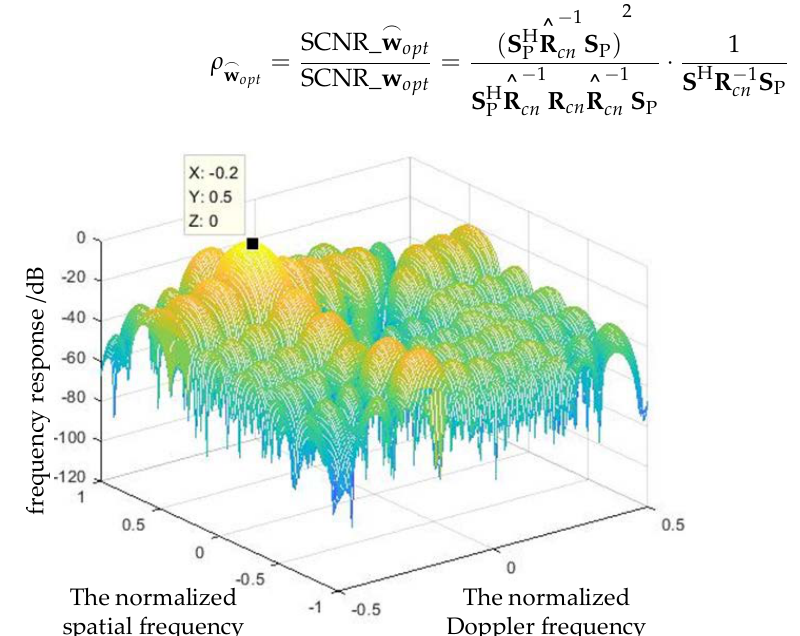
Figure 3. The 2 − D frequency response of the optimum STAP.